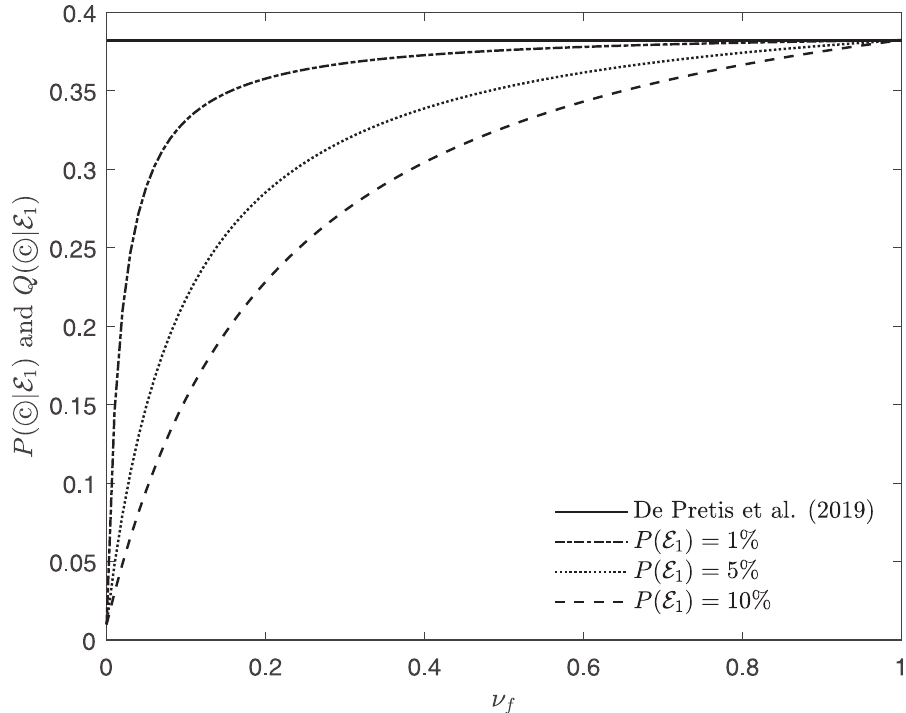
Fig 4. Posterior probability of the causal hypothesis © , considering Beasley et al. (2011) [77] as evidence E computed in agreement with De Pretis et al. (2019) [78] (solid line) and EA 3 (dash-dot, dotted and dashed lines). For EA 3 , different lines represent different priors P ð E ν f = 1 where De Pretis et al. (2019) [78] becomes a special case of EA 3 .